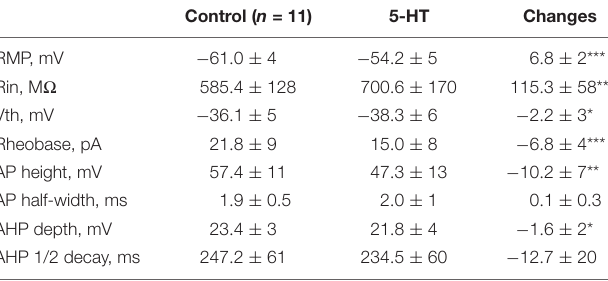
TABLE 1 | 5-HT effects on membrane properties of serotonin neurons. Control ( n = 11)